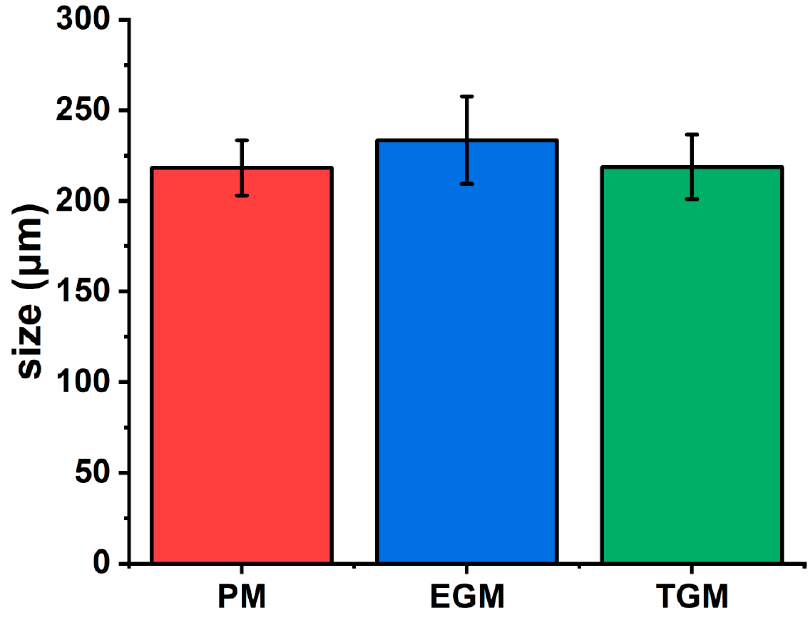
Figure 1. Microscopic images of microspheres: ( A ) PM in DI water; ( B ) PM in PBS; ( C ) EGM (0.75% gelatin) in PBS; ( D ) TGM (0.75% gelatin) in PBS. Arrows indicate highly swollen and disappearing PM. The scale bar represents 500 μ m.